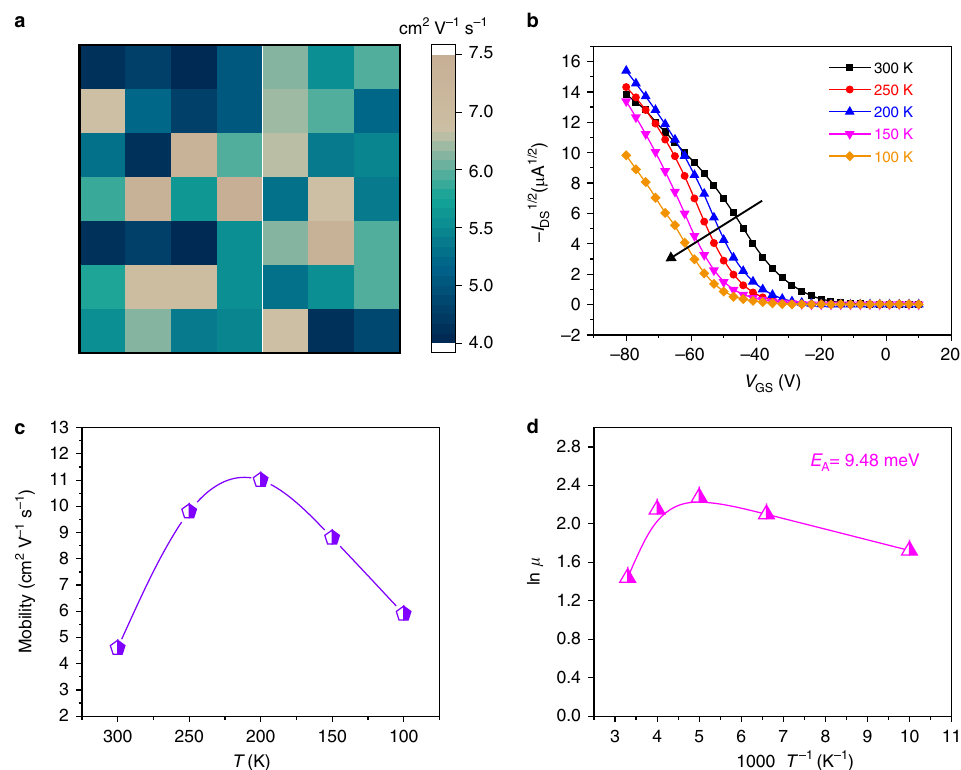
Fig. 2 Electrical properties of DPA-based TFTs. a Distribution of TFT mobilities. b Square root of drain current ( − I DS 1/2 ) versus gate voltage ( V GS ) measured at different temperatures. c Temperature dependence of mobility. d ln( μ ) versus 1000/